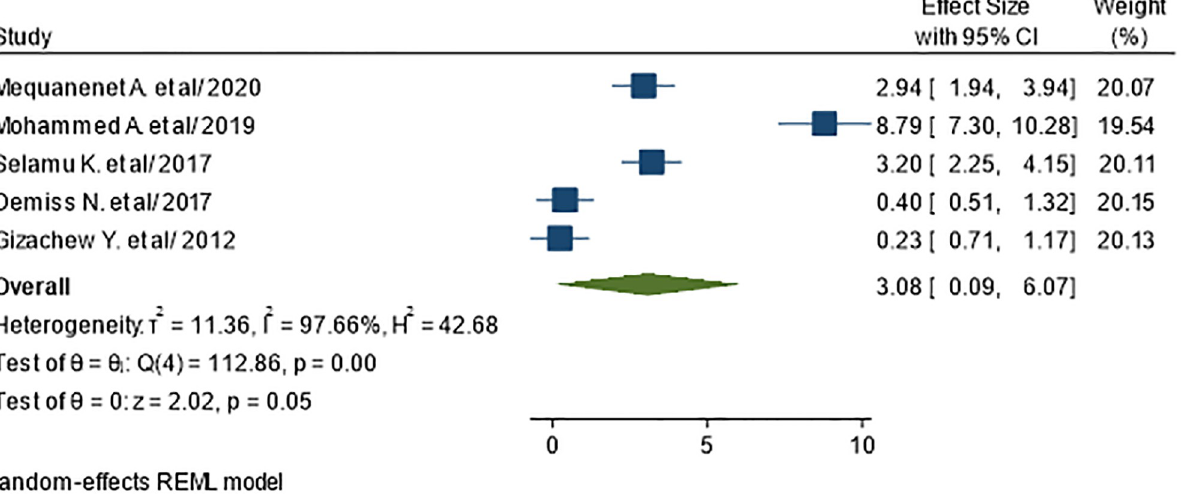
S1 Table. Methodological quality assessment of included studies using Joanna Brigg’s Institute quality appraisal criteria scale (JBI). The eight item questions assessing inclusion criteria, study setting and participant, exposure measurement, objectives, confounder, stati- cally analysis, outcome measurement and dealing confounder were used.